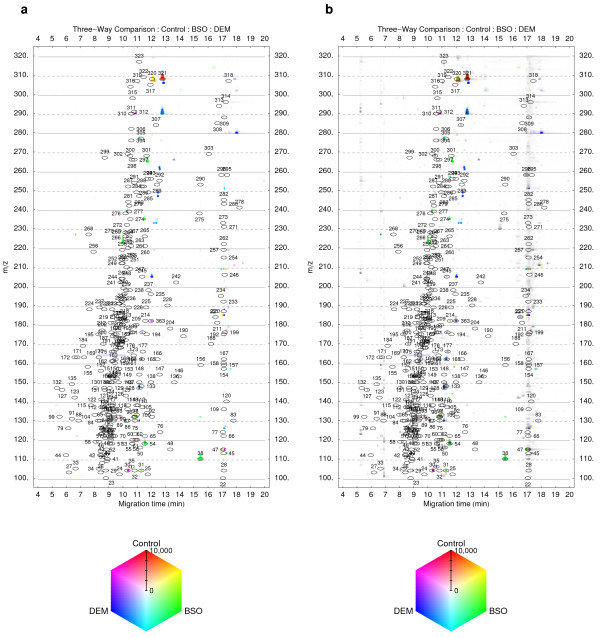
Three-way comparison of metabolite profiles. (a) Absolute × relative three-way comparison of metabolite profiles shown in Figure 2. Averages of replicate datasets (n = 5) were used for the three-way comparison. The resulting dataset was filtered using F-ratio (one-way ANOVA) to select only statistically significant differences as described in the main text. (b) The Control dataset (Figure 2a) was overlaid on the three-way comparison result shown in panel (a) via the brightness value. Darkening of the colored spots indicates the size of the corresponding peaks in the Control dataset. Gray spots show peaks which do not significantly differ among the datasets. For both plots, numbered ovals (annotation labels) indicate the expected locations of peaks of a set of known chemical compounds and are used for identification of metabolites on the density plots [2,3].